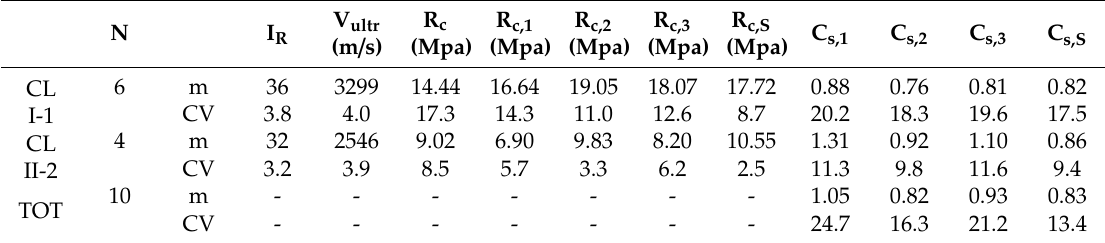
Table 5. Sonic–Rebound (SonReb) method results: cubical compressive strengths and corrective coe ffi